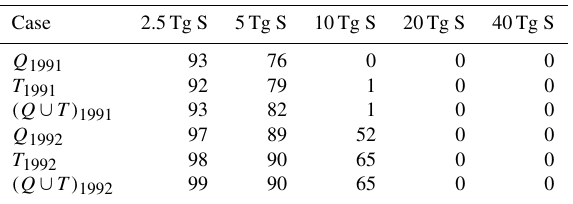
Table 2. Number of ensemble members lying within the 2 standard deviations of the corresponding control run values with respect to temperature ( T ) or specific humidity ( Q ) or their union ( Q ∪ T ) in 1991 and 1992.